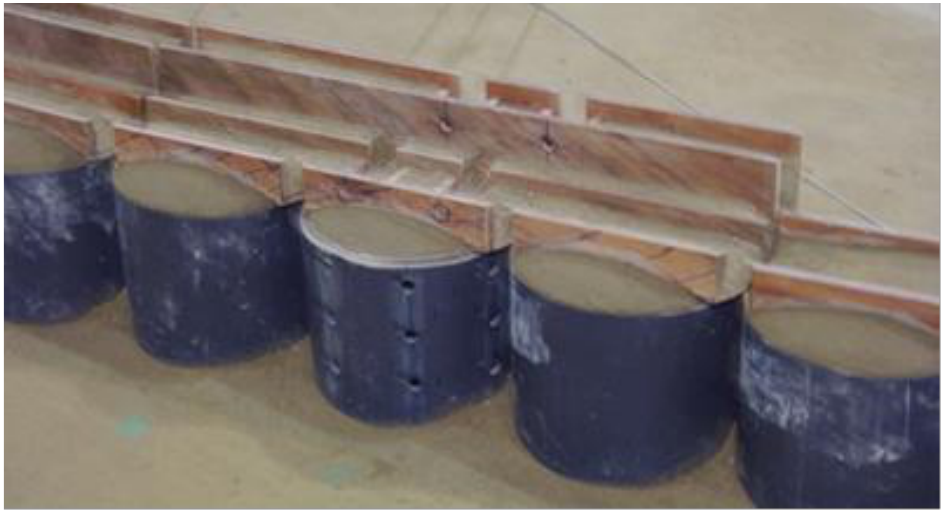
Figure 6. Model caissons made from UPVC pipe sections, plywood and mortar. The upper wave walls were simplified from four to two steps between lower and upper walkways. The up-stand walls were formed in plywood, with cement mortar used